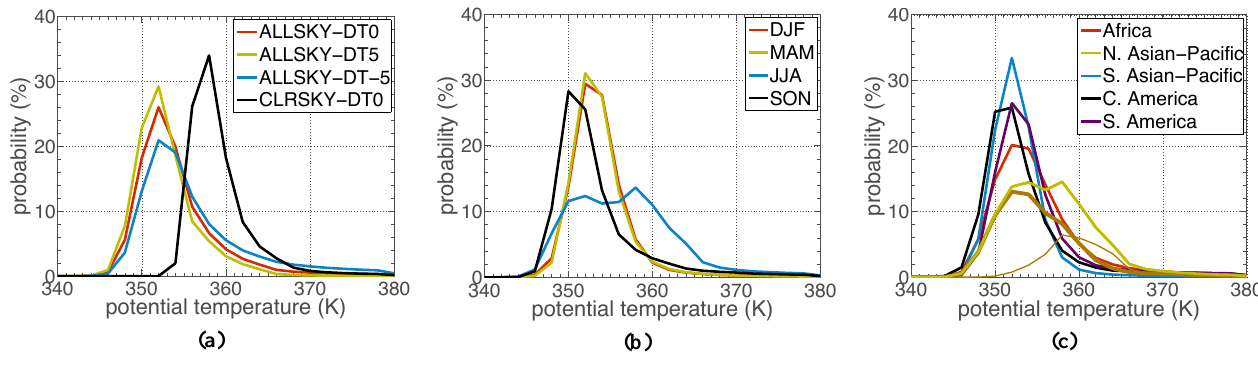
Fig. 8. Same as Fig. 6 but this time the focus is on the histograms of potential temperatures at which encounters with convective sources have taken place. Also shown in (c) are the histograms corresponding to trajectories detrained over the land (thin brown line) and ocean (thick brown line) parts of the north Asian-Pacific region (respectively defined as NAPL and NAPO in Fig. 2) The histograms are calculated using a bin size of 2K in potential